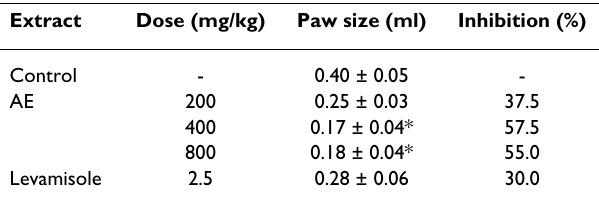
Table 9: Effect of extract on SRBC-induced DTHR Extract Dose (mg/kg) Paw size (ml) Inhibition (%) Control - 0.40 ± 0.05 - AE 200 0.25 ± 0.03 800 Levamisole 2.5 0.28 ± 0.06 n = 4; AE = Aqueous extract; * P < 0.05 ( ANOVA; LSD post hoc ); SRBCs = Sheep red blood cells; DTHR = Delayed type hypersensitivity